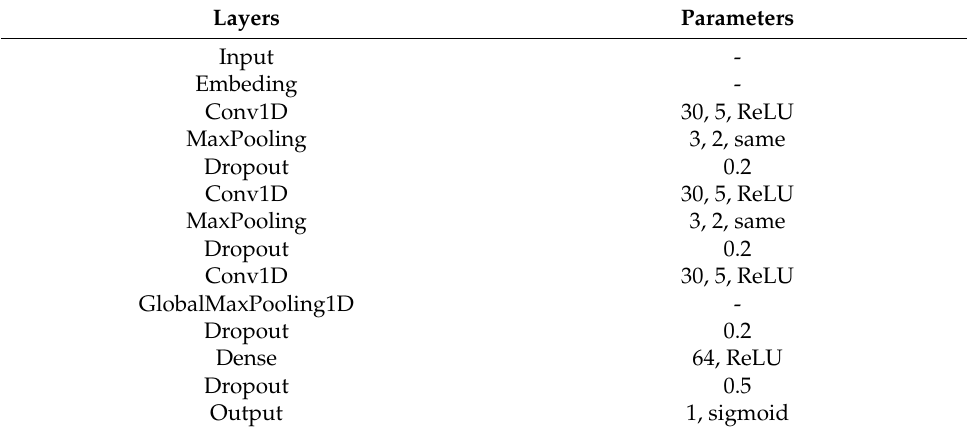
Table 1. Topology of the CNN model.